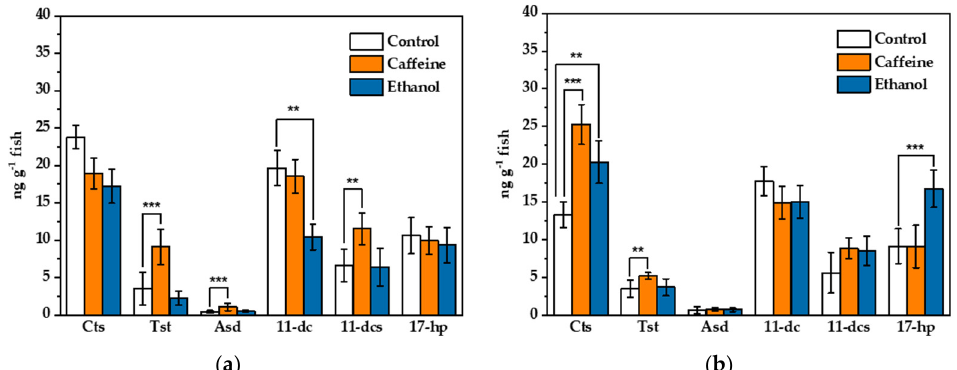
Figure 3. Steroid hormone levels in zebrafish male ( a ) and female ( b ) adults after caffeine (300 mg/L) and ethanol (1%) acute exposure (5 min), respectively. The level of each steroid hormone in individual fish was calculated by amount/body weight (ng/g). Data are presented as mean ± s.e.m. Two-way ANOVA ( n = 10). Abbreviations: Cts, cortisol; Tst, testosterone; Asd, androstenedione; 11-dc, 11-deoxycortisol; 11-dcs, 11-deoxycorticosterone; 17-hp, 17-hydroxyprogesterone. *** indicates statistical significance at p < 0.01. ** indicates statistical significance at p < 0.05.